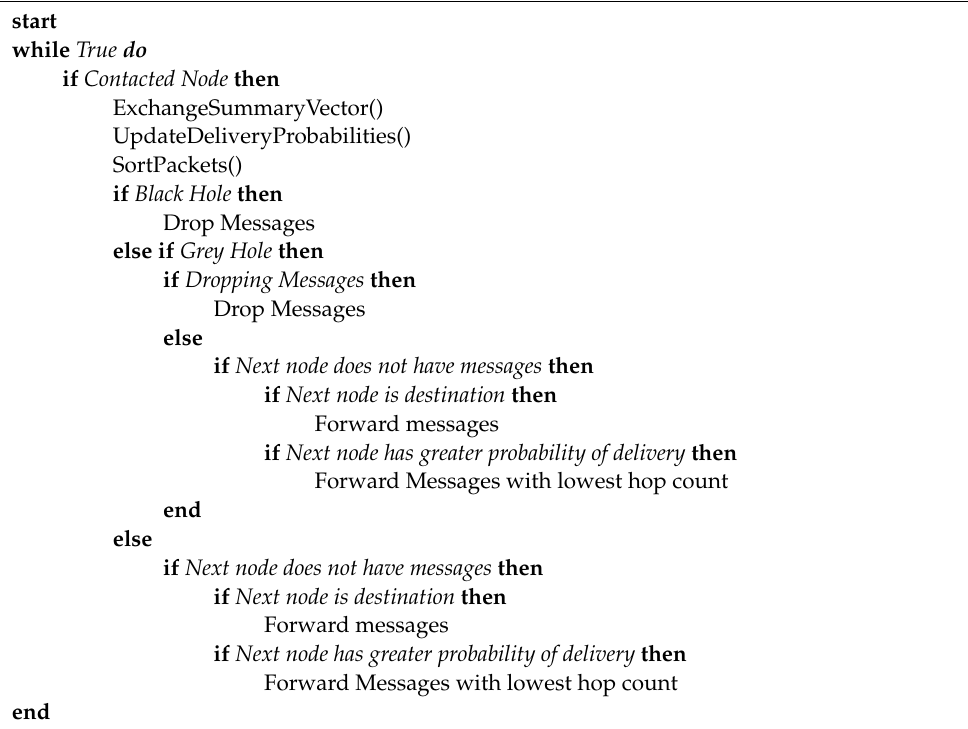
Algorithm 4. Black and Grey Hole MaxProp Router